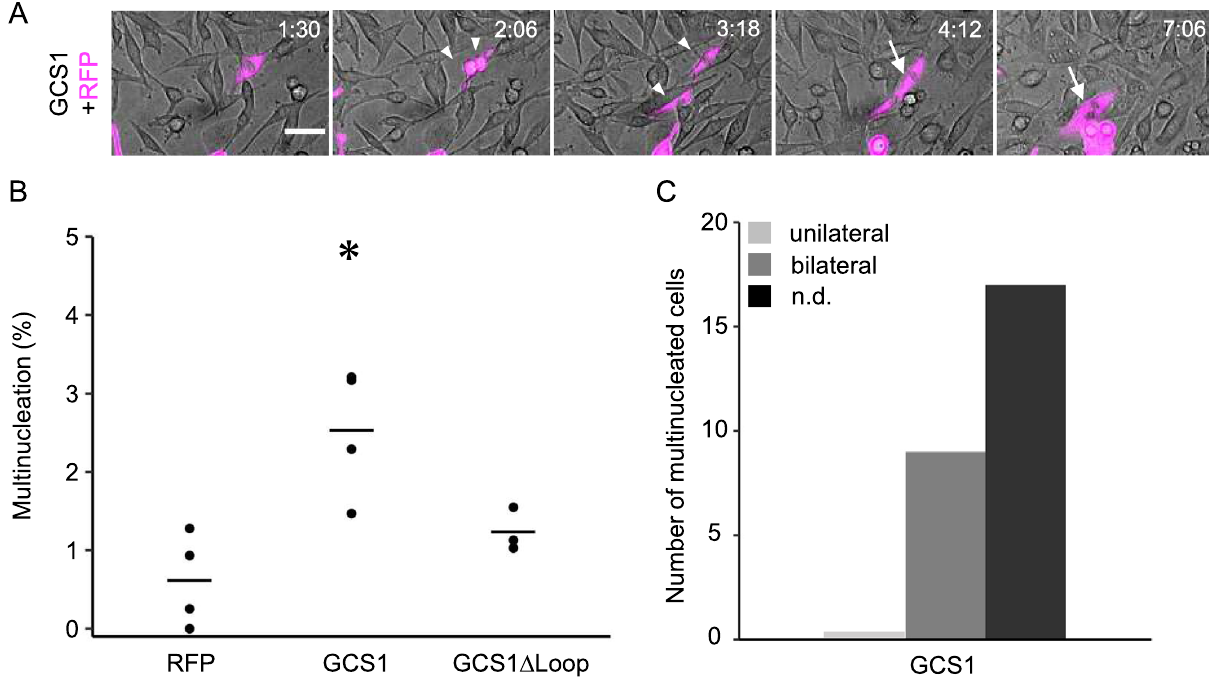
Figure 1. Quantification of multinucleation using live imaging. ( A ) Time-lapse images from a fusion assay. Baby hamster kidney (BHK) cells were transfected by plasmids for expression of red fluorescent protein (RFP) (magenta) and GCS1 (co-transfection). Arrowheads and arrows indicate contacting and fused cells, respectively. Time (h:min) after the start of observation is shown (see Video 1). Bars: 20 µm. ( B ) Multinucleation frequency of BHK cells determined by the expression of GCS1 and GCS1∆Loop. The use of mutant proteins GCS1∆Loop is explained in detail in the text. Dots indicate multinucleated cells among cultured cells, determined using a fusion assay; bars indicate the average values. Dunnett’s test was used to compare each gene to the negative control. * P < 0.05. ( C ) Dependency of cell–cell fusion on co-transfected RFP expression. Bars represent the numbers of multinucleated cells, determined by fusion of RFP-labelled and non-labelled cells (unilateral fusion, light grey bars), fusion of RFP-labelled cells (bilateral fusion, dark grey bars), and fusion of non-labelled cells (not determined, black bars; all cells in this category began to express RFP after